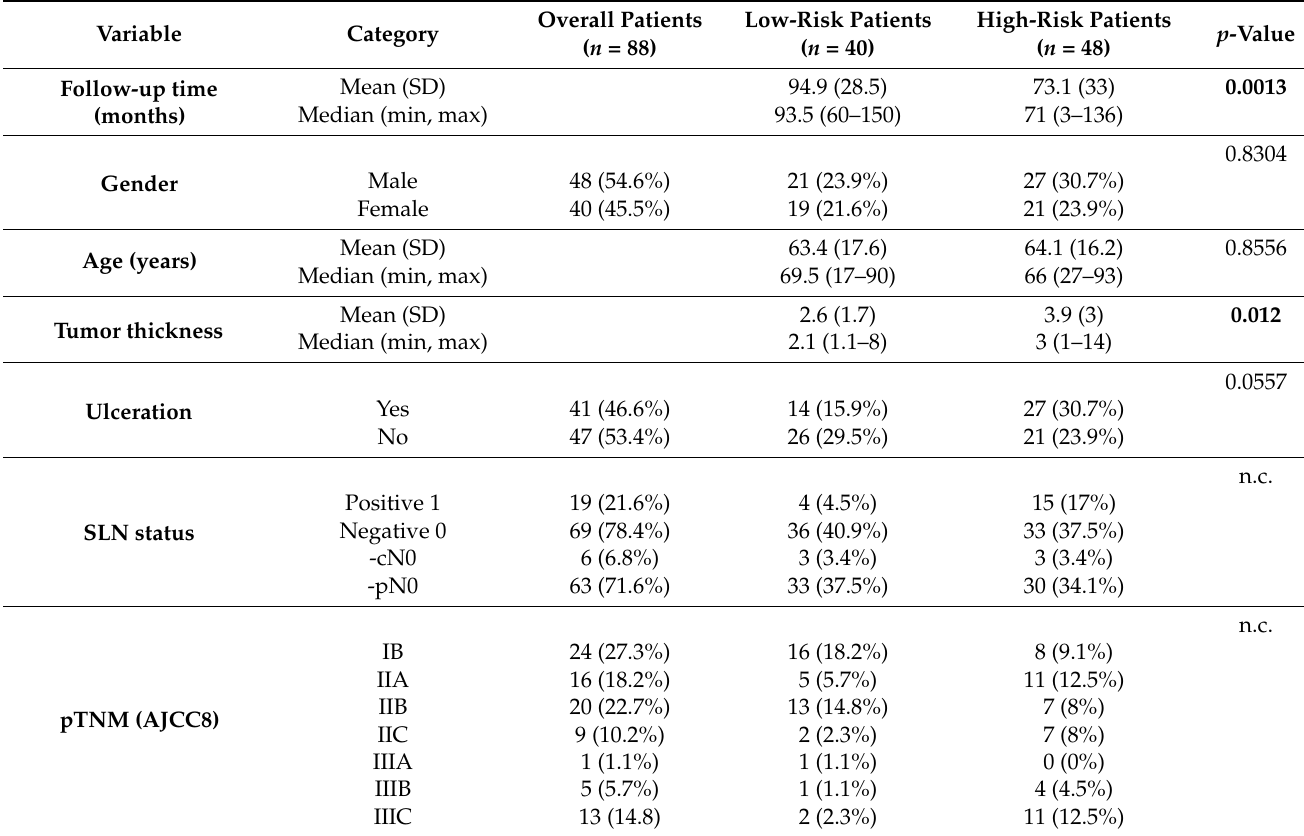
Table 1. Patient and clinicopathological characteristics of the low-risk and high-risk group (all, stage IB–IIIC).